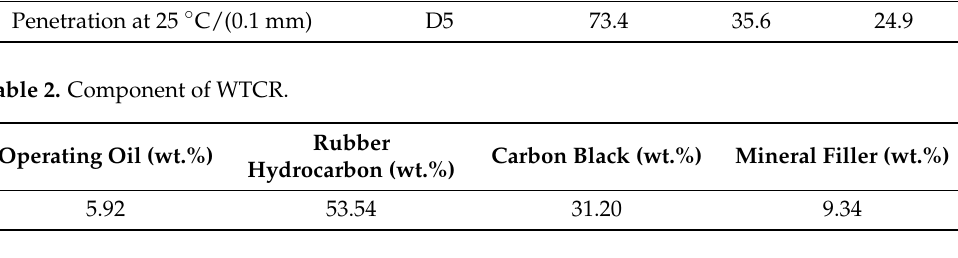
Table 3. Main physical and chemical properties of